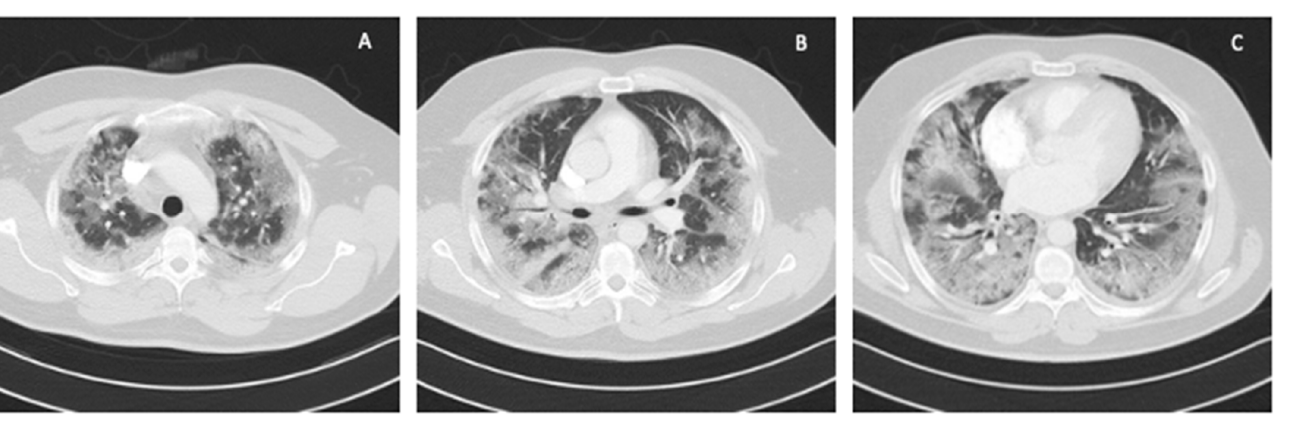
Figure 1. Chest CT scan on admission to the ICU: ( A )upper lung segments; ( B )middle lung segments; ( C )basal lung segments (Case 1). ( C ) basal lung segments (Case